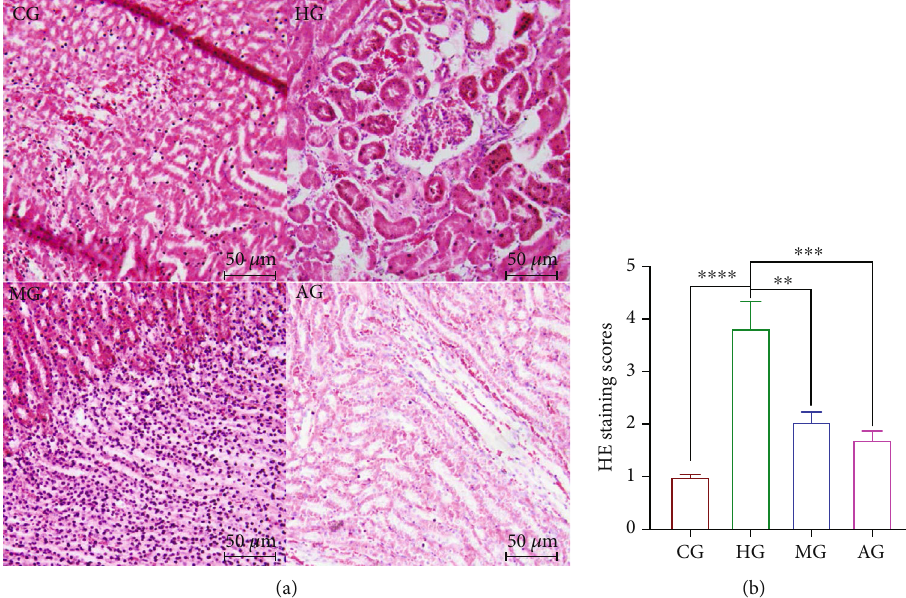
Figure 3: Hematoxylin and Eosin (H&E) staining of the kidney injury. (a) H&E-stained glomeruli or renal tubules. (b) H&E-stained histological scores. Magni fi cation: 100x; scale bar: 50 μ m. n = 3 for each group, and ∗∗ P < 0 : 01 , ∗∗∗ P < 0 : 001 , and ∗∗∗∗ P < 0 : 0001 vs. the HG group.